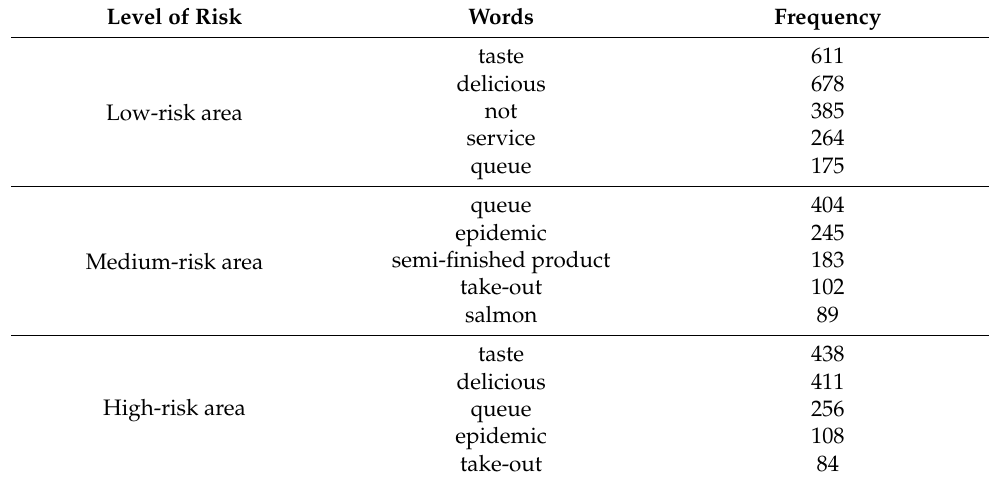
Table 5. Distribution of words after